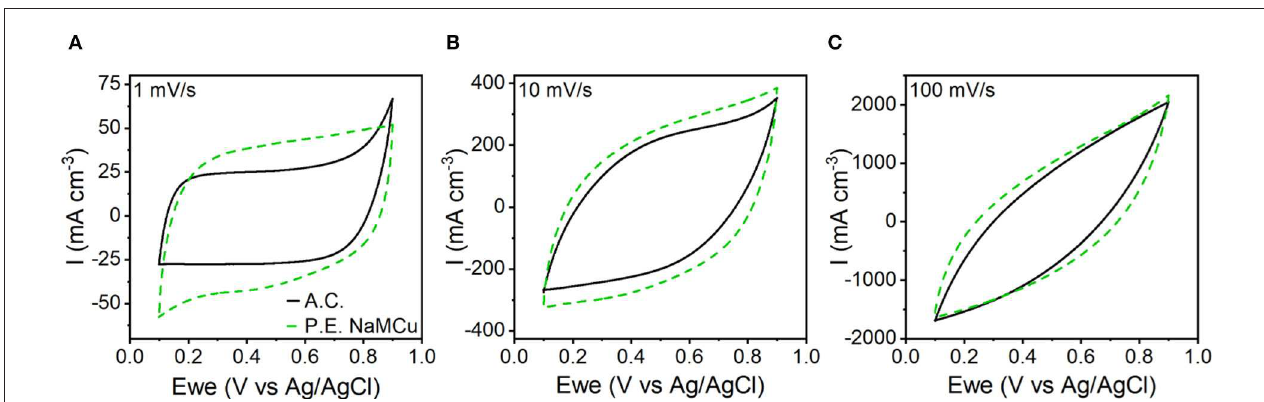
FIGURE 8 | CV comparison of P.E. NaMCu and activated carbon (A.C.) on the basis of their specific current at (A) 1 mV/s, (B) 10 mV/s, and (C) 100 mV/s. At sweep rates up to ∼ 20 mV/s, the P.E. NaMCu out-performs the activated carbon, although both electrodes appear relatively resistive at 100 mV/s.